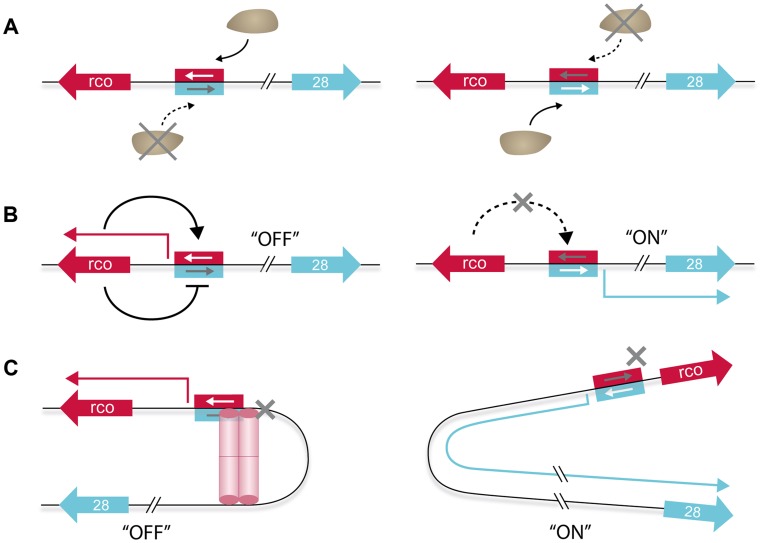
Model of the different layers contributing to the genetic switch controlling expression of the pLS20 conjugation genes.
A. RNA polymerase acts itself as a switch because it is unable to bind simultaneously to both of the two overlapping and divergently oriented promoters. Consequently, RNA polymerase (the brown ellipse shaped form) binds only one promoter at a time resulting in transcription of only the gene(s) controlled by this promoter. B. RcoLS20 generates a self-sustaining positive feedback loop by activating transcription from its own promoter (Pr) (left panel). This, combined with the simultaneous repression of the divergent conjugation promoter (Pc), results in conjugation being maintained effectively in the “OFF” state. Relief of RcoLS20-mediated repression of the Pc promoter results in activation of the conjugation genes (right panel). In addition, this interrupts the auto-stimulation of the Pr promoter, preventing further synthesis of RcoLS20, which in turn will contribute in pushing and maintaining conjugation in the “ON” state. The negative auto-regulatory loop of RcoLS20 that probably functions to keep RcoLS20 within a low concentration range (see text) is not presented. C. DNA looping results in a high local concentration of RcoLS20, increasing specificity and affinity that dampens transcriptional fluctuations between and within individual cells (left panel). This would contribute to tight repression of the Pc promoter, keeping conjugation in the “OFF” state under conditions antithetic to conjugation without compromising the ability to switching rapidly to a high expression state (i.e. “ON”, right panel) of the conjugation genes when appropriate conditions occur. rcoLS20 and gene 28, -the first gene of the conjugation operon-, are indicated with large red and blue arrows, respectively. The same coloring scheme is used for the corresponding promoters (rectangular) and transcripts (thin broken arrows). Activation and repression of transcription are indicated with continuous black lines ending in an arrow and a “T” shape, respectively. The red cylindrical structures, which may reflect one or two RcoLS20 tetramers, represent the RcoLS20 oligomer mediating DNA looping.